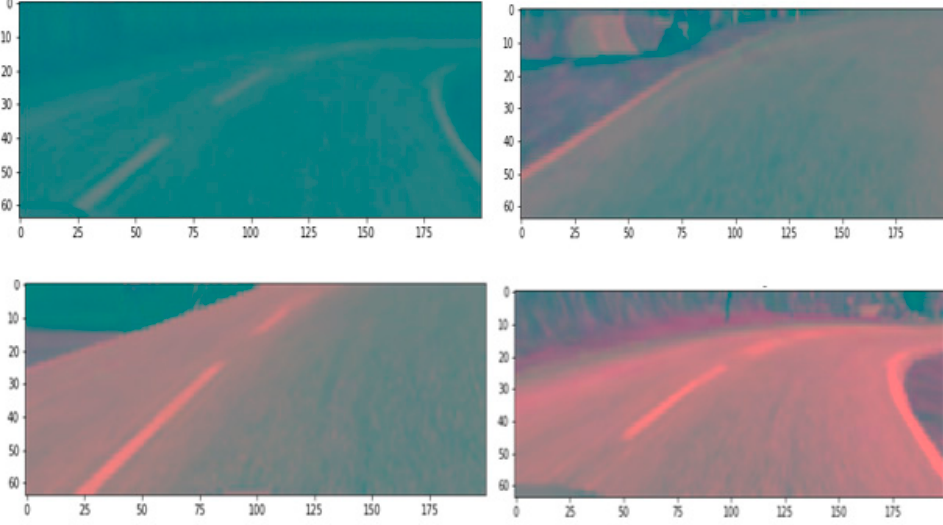
Figure 26. Sent Pre-processed image at testing time of the vehicle.